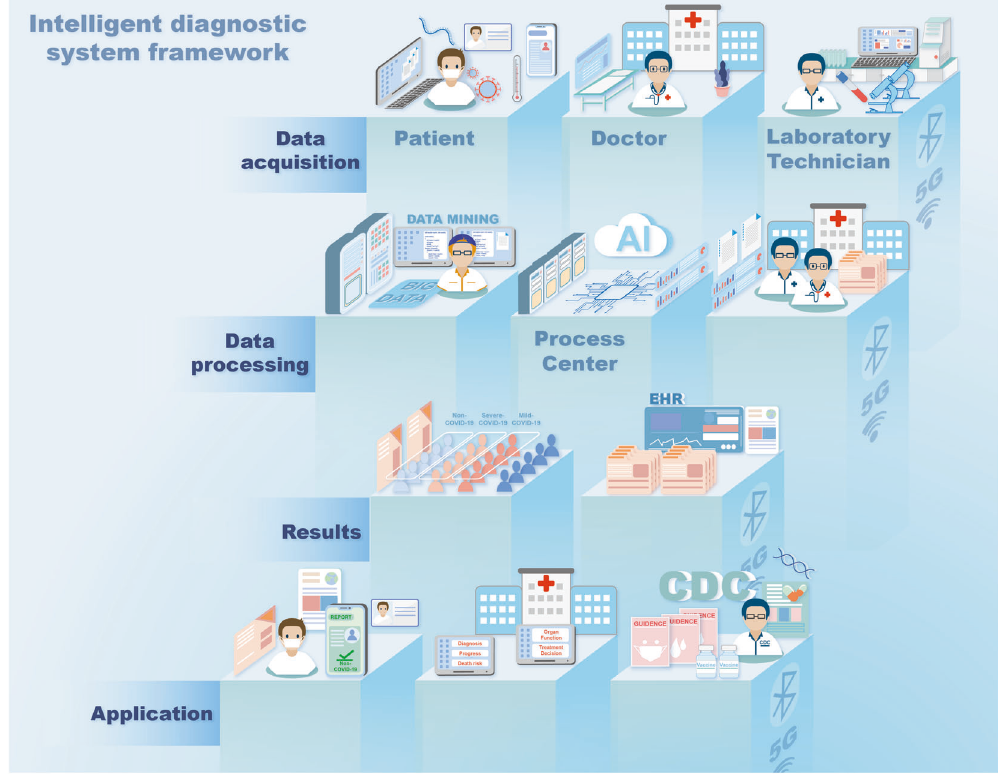
Fig. 6 Intelligently assisted individualized diagnosis and treatment system for